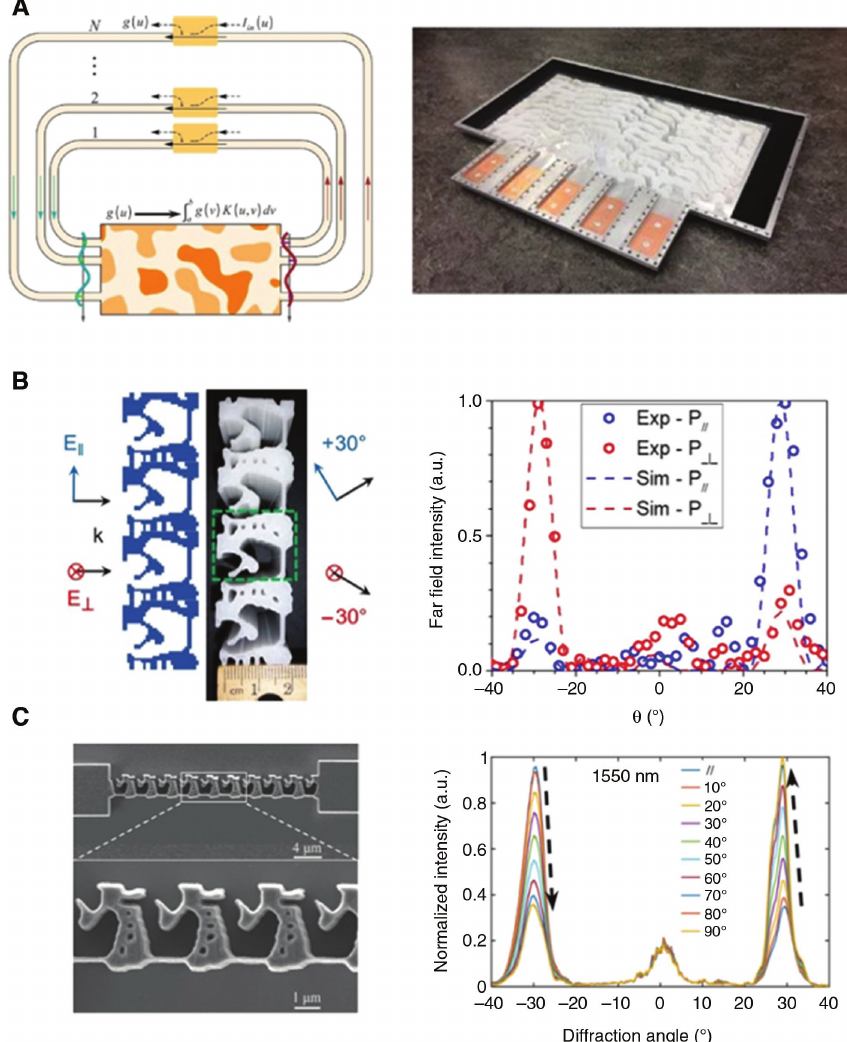
Figure 9: Inverse-designed metastructures. (A) Left: Sketch of a closed-loop network, consisting of a suitably designed kernel operator (metamaterial block), feedback mechanism, and in/out coupling elements to excite and probe the waves. The N waveguides realize the external feedback network. The direction of the wave flow is indicated by arrows. Right: Photograph of the constructed metamaterial. Adapted from Ref. [118]. Copyright (2019) AAAS. (B) Left: Schematic drawing and top-view photograph of the 3D-printed inverse-designed 30 ° polarization splitter. With parallel(vertical) electric-field polarization E (E ), the input plane wave is bent to + 30 ° (−30 ° ). Right: Simulated (dashed line) and measured (circles) far-field ⊥ || power profiles for both parallel and perpendicular polarizations. Adapted from Ref. [119]. Copyright (2018) Nature Publishing Group. (C) Left: Scanning electron micrograph of the top view of the printed device. Right: Normalized experimental transmitted intensity of the fabricated sample as a function of diffraction angle for various input polarization angles. Adapted from Ref. [120]. Copyright (2019) John Wiley &